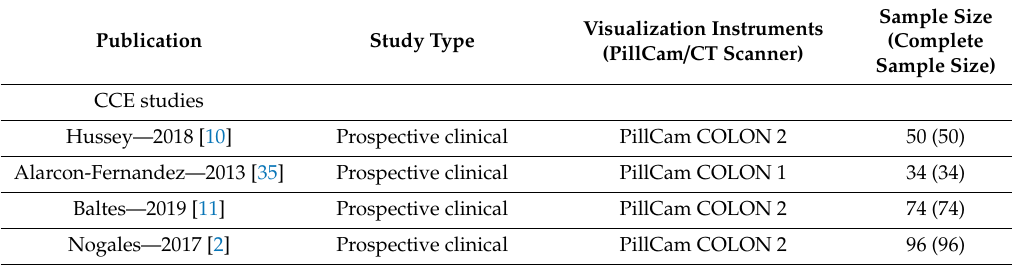
Figure 1. Flow of references from the initial literature search 10th of September 2020 on colon capsule endoscopy vs. CT colonography following incomplete colonoscopy. CTC: computed tomography colonography, CCE: colon capsule endoscopy and IC: incomplete colonoscopy. Table 2. Overviewof26studiesincludedformeta-analysisoncoloncapsuleendoscopyvs. CTcolonography after incomplete